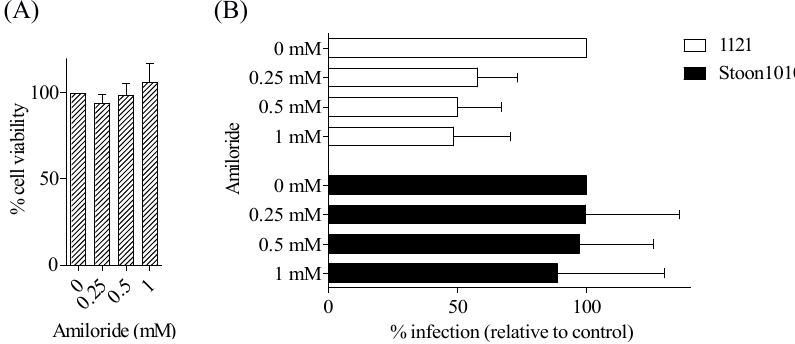
Figure 7. PCV2 internalization into T-lymphoblasts. Cells were incubated with PCV2 particles at 37 ◦ C for 1 h, after which the virus was removed and cells were fixed. PCV2 particles were stained in green, while T-lymphoblasts were stained in red. ( A ) Visualization of PCV2 particles internalized into T-lymphoblasts was performed by confocal microscopy. Some green virus particles were sticking to the cell membrane, while others were found inside the red cell rings and were regarded as internalized particles. Scale bar = 8 µ m. ( B ) The percent of T-lymphoblasts with virus (total particles = surface sticking particles + internalized particles) and the percent of T-lymphoblasts with internalized particles was counted. ( C ) The fluorescing area of total virus particles and internalized virus particles per cell was quantified with ImageJ. Data represent means ± SD of triplicate assays. * p < 0.05.